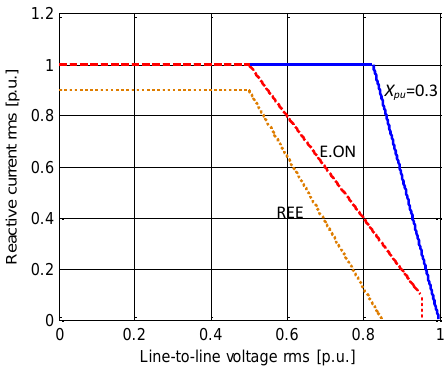
Figure 3. The voltage support characteristics when X pu = 0.3 compared with the grid codes’ requirements.